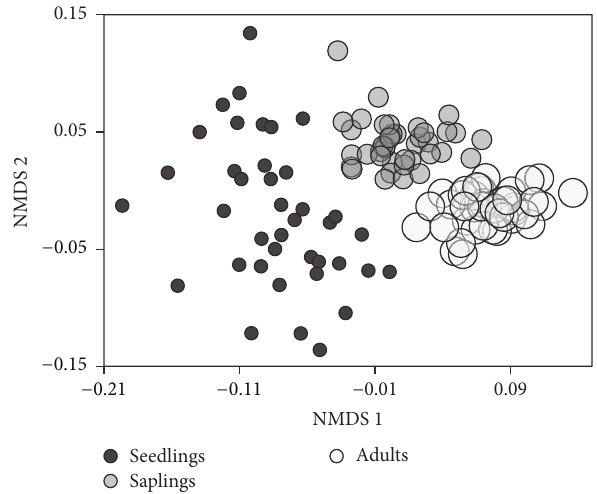
Figure 2: Nonmetric Multidimensional Scaling analysis (NMDS) ordination diagram of the 120 plots based on species abundance for seedlings (height ≥ 10 cm and DGH ≤ 1cm), saplings (DGH > 1cm and DBH < 3 cm), and adult trees (DBH ≥ 3 cm) in Riacho Fundo swamp gallery forest, Central